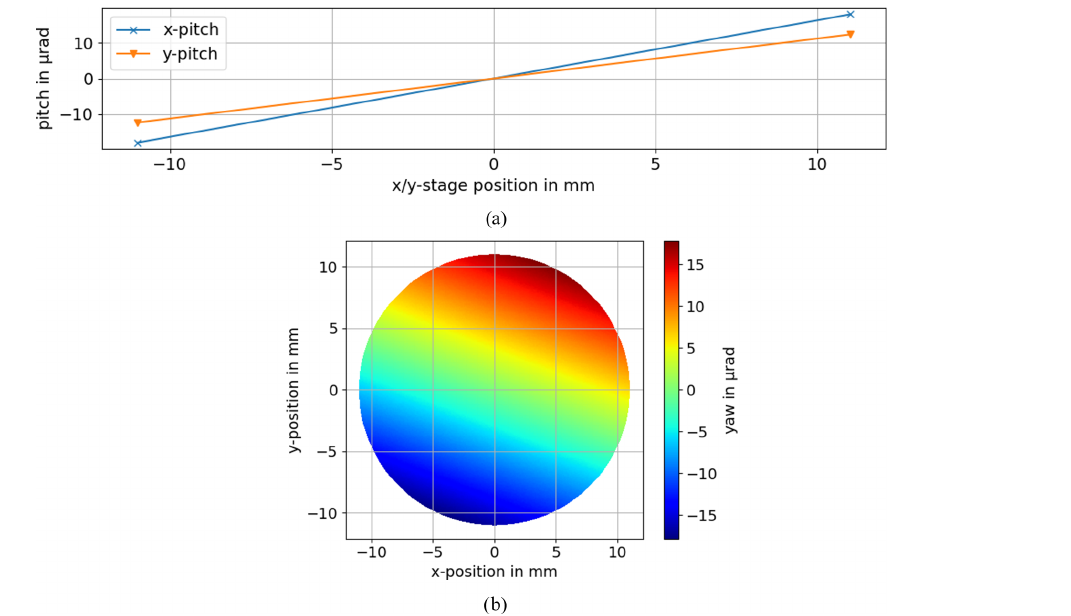
Figure 7. (a) Evolution of the assumed pitch for the x and y stages for the simulation. (b) Evolution of the yaw, rotation around the z axis, dependent on the sample point